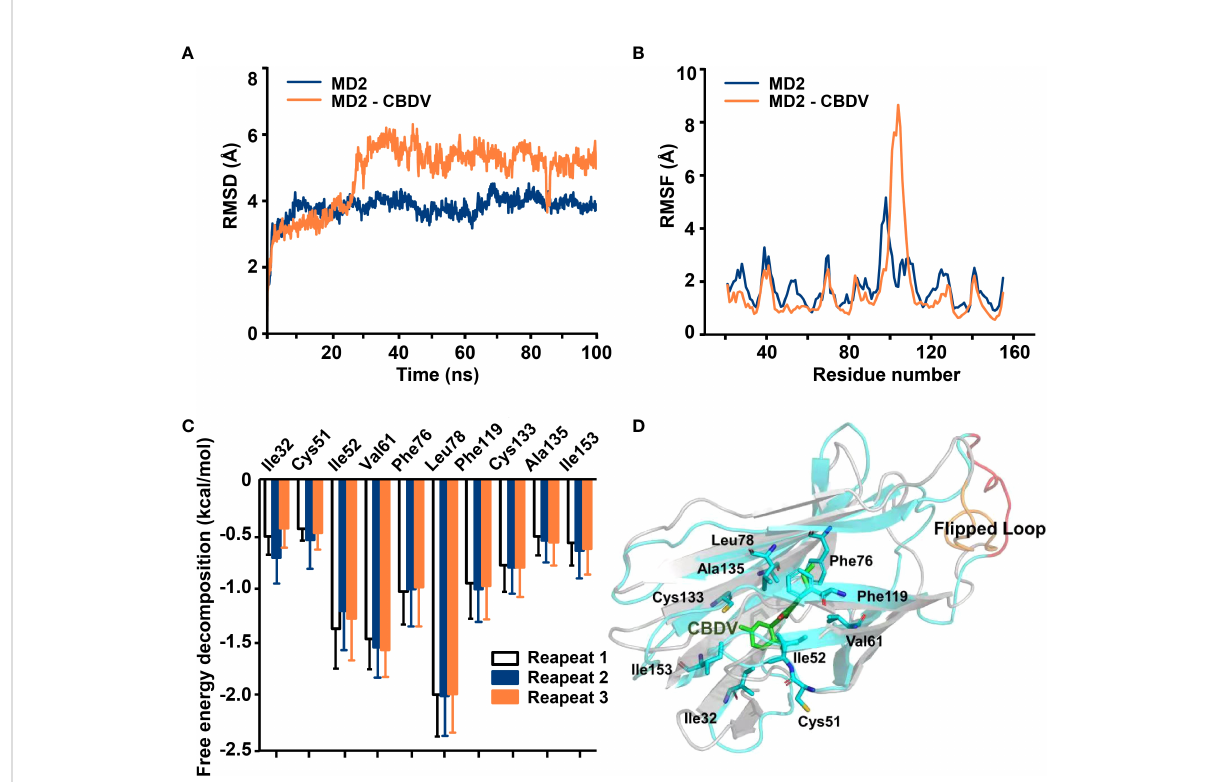
FIGURE 2 In silico simulation of CBDV interacting with MD2. (A) Time evolution of RMSDs for apo-MD2 and CBDV-bound MD2 (MD2-CBDV) during the MD simulations at 310 K. (B) Time evolution of RMSFs of MD2 and CBDV bound MD2 during the MD simulations at 310 K. (C) Per-residue energy decomposition for key residues. (D) The representative binding mode of CBDV with MD2 at 310 K after MD simulation. CBDV was shown as ball-stick model. MD2 in the MD2-CBDV system was shown as cartoon model (cyan) aligned to apo-MD2. Key residues of MD2 in interacting with ligands were shown as sticks. The fl ipped loops were labeled with orange and red in apo-MD2 and MD2-CBDV,